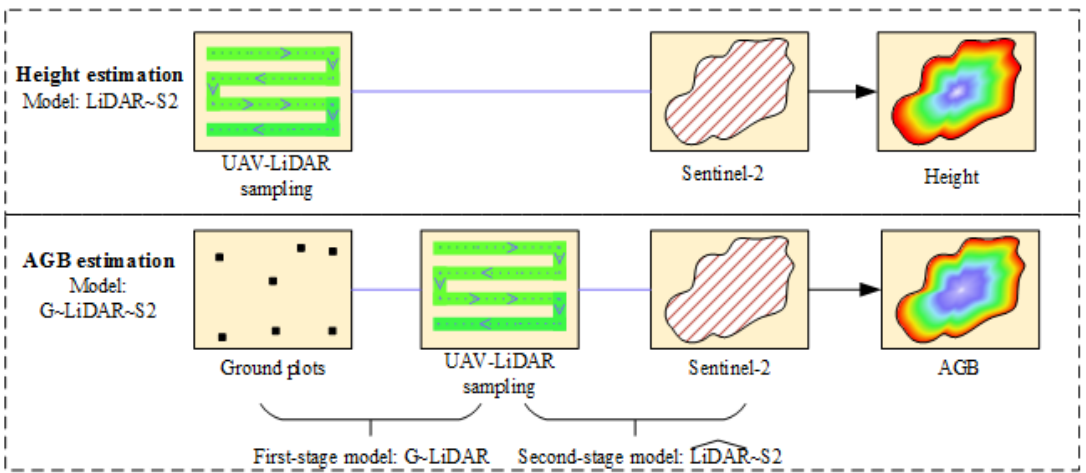
Figure 3. Schematic graph of the UAV-LiDAR sampling method for height (top graph) and AGB (bottom graph) estimations.